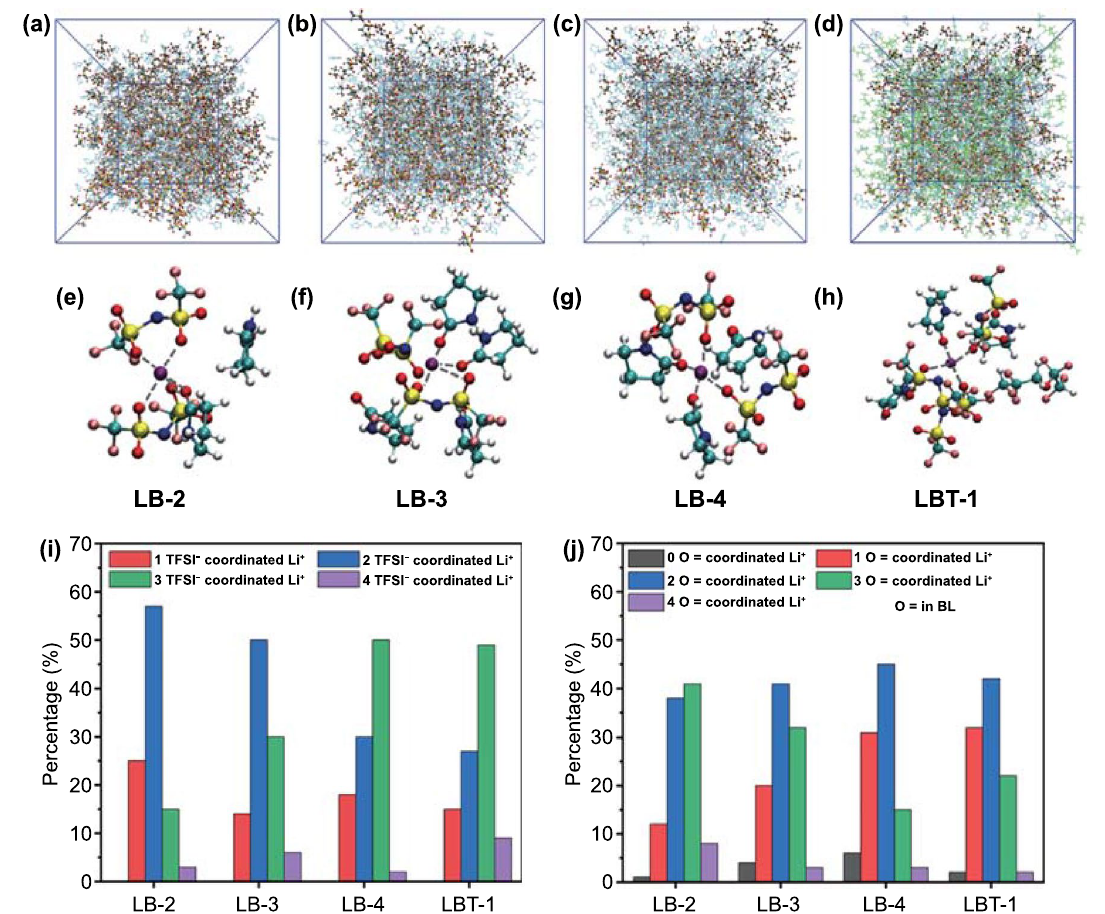
Fig. 2 AIMD simulation snapshots of a LB-2, b LB-3, c LB-4 and d LBT-1 at 298 K. Ball and stick model stand for LiTFSI, while BL (blue) and TTE (green) are presented by wireframes. Representative Li + coordination structure in e LB-2, f LB-3, g LB-4 and h LBT-1. Percentage of Li + coordination structure in different electrolytes based on MD simulation. i Percentage of Li + cations coordinated with different number of TFSI − anions in LB-2, LB-3, LB-4 and LBT-1. j Percentage of Li + cations coordinated with different number of BL molecules in LB-2, LB-3, LB-4 and LBT-1(O = represents the O atom in